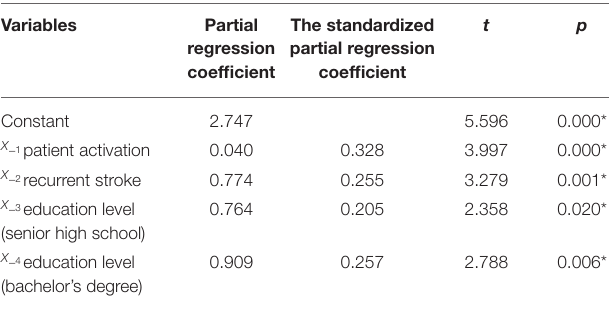
TABLE 6 | Multivariate analysis of medication adherence ( n =